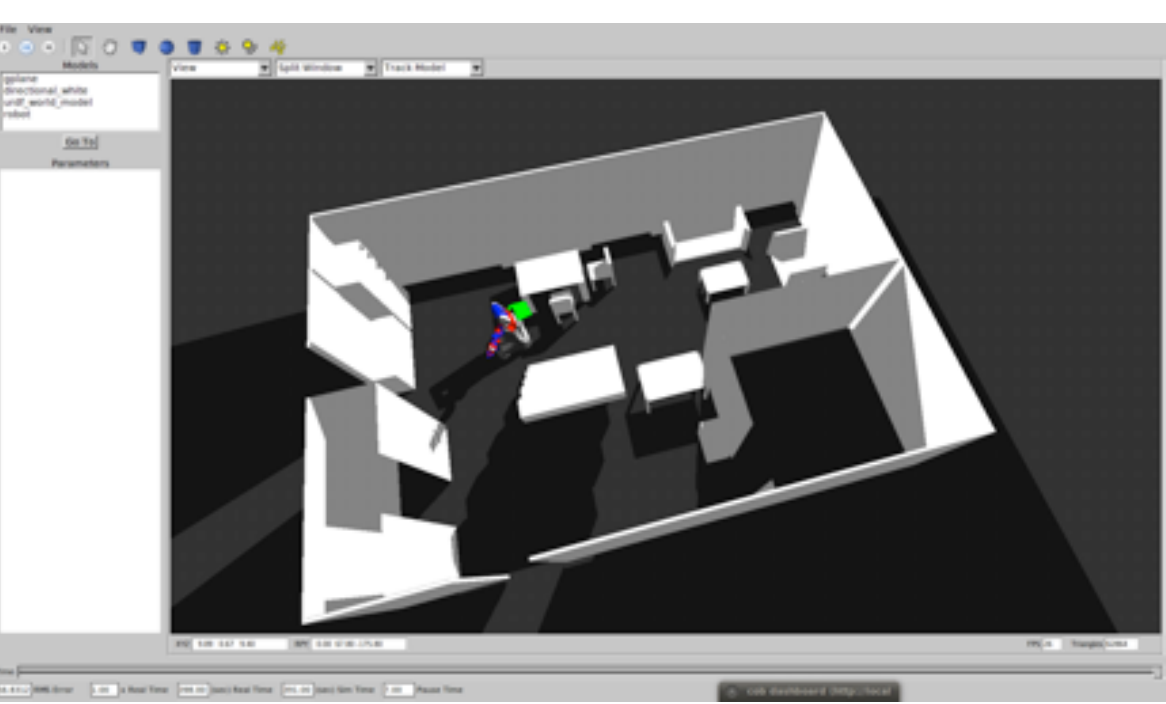
Figure 12. Simulation environment of the robot house allowing developments in absence of robot and robot